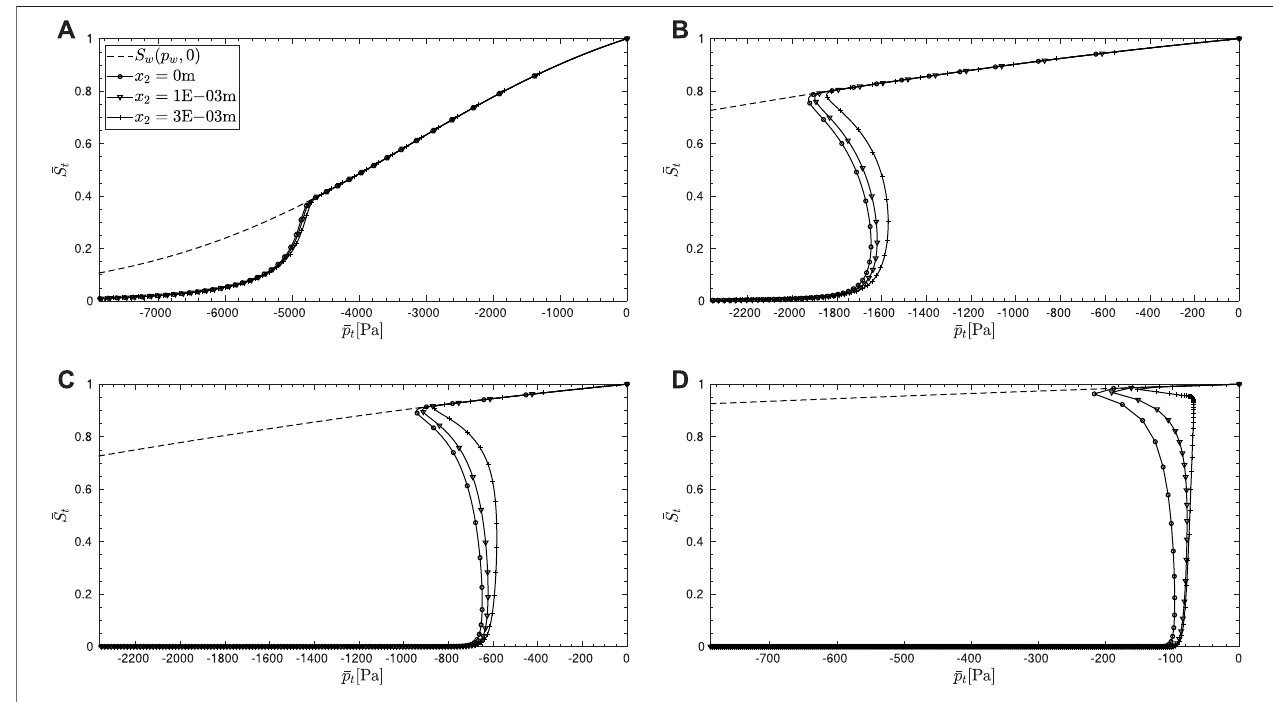
FIGURE5| Pathfollowedbythesolutioninthespace( S t , p t )attheboundary x 2 =0mandtwolocationswithinthedomainclosetothisboundaryforvaluesof w 1 (A) 2000 N.m − 3 (B) 1000 N.m − 3 , (C) 500 N.m − 3 , and (D) 100 N.m − 3 . The dashed line represents the standard non-degraded retention curve.